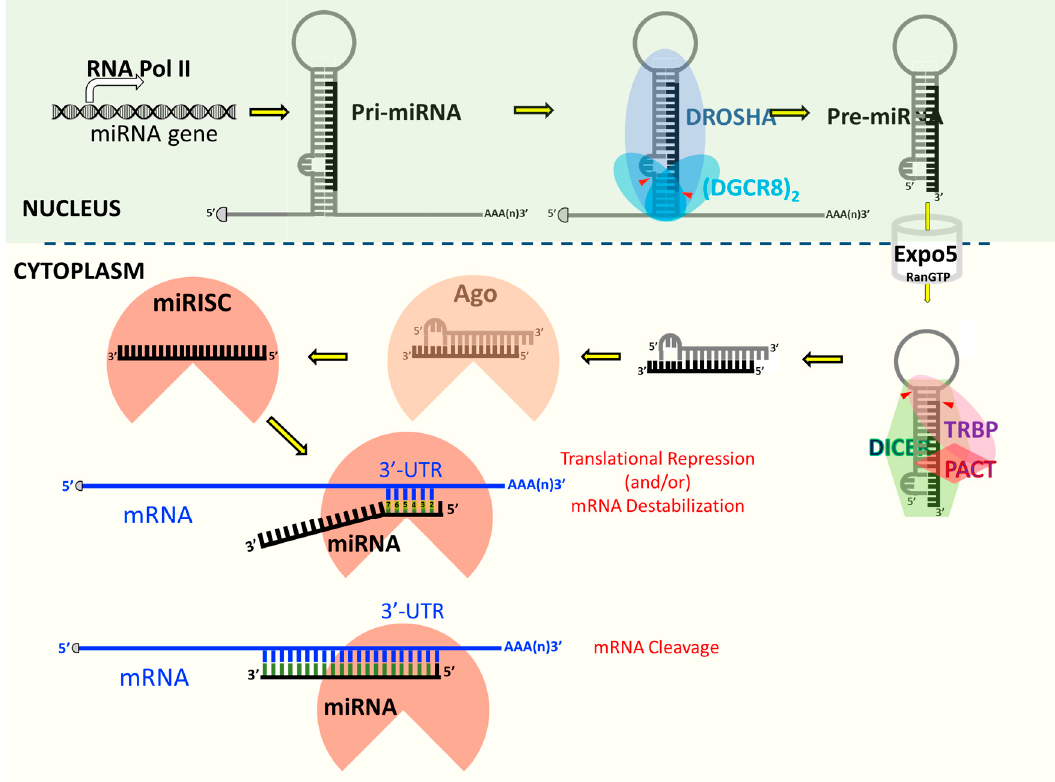
Figure 1. Schematic representation of the canonical microRNA (miRNA) biogenesis pathway in humans: The RNA Polymerase II transcribes the nuclear chromosome-encoded miRNA gene into primary miRNA (pri-miRNA) that comprises a stem, a terminal loop, and single-stranded 5 ′ and 3 ′ RNA tails. The nuclear microprocessor complex-resident Drosha, in concert with its cofactor DGCR8, recognizes the pri-miRNA and cleaves asymmetrically at defined sites in the stem. The released stem- loop structure termed precursor miRNA (pre-miRNA) is then transported to the cytoplasm by the Exportin 5-RanGTP protein complex. The cytoplasmic Dicer, in concert with potential cofactors like